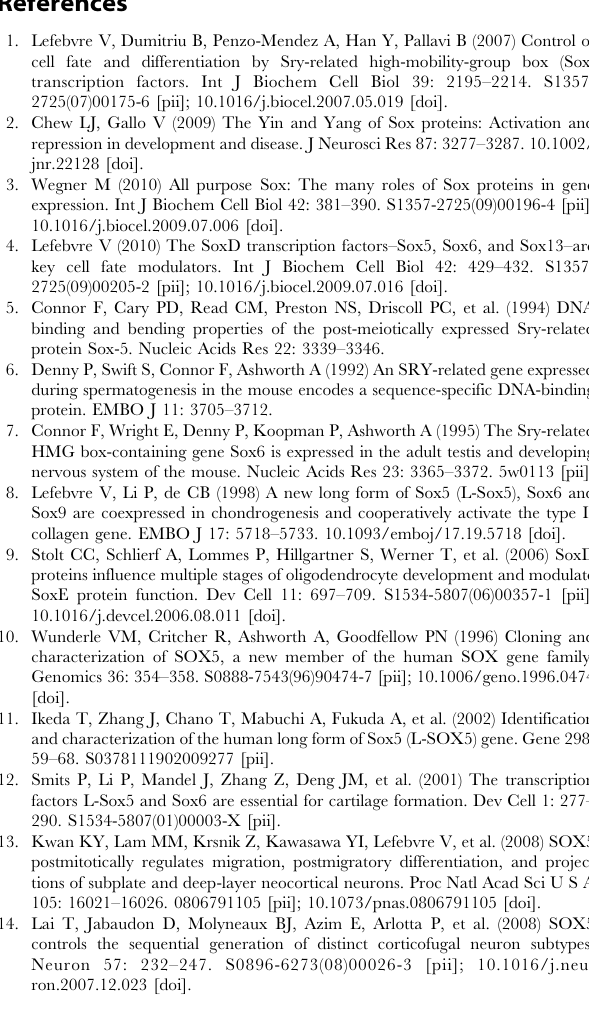
RAJI cell fractions. In agarose gel pictures DNA markers were cut out, since they were loaded between the tested samples and the control sample. Human costal cartilage cells served as a control. Figure S4 Expression of human cell cycle genes in SOX5-transduced and in vitro differentiated human primary B cells. Human cell cycle RT2 Profiler PCR Array containg 84 pathway specific genes were run for RNA samples of GFP- and SOX5-GFP-transduced human primary B cells at day 3 upon CD40L + IL4 + IL21 stimulation in vitro. Negative regulatory genes of cell cycle are indicated in red, whereas positive regulatory genes of cell cycle are depicted in green. Black color shows the regulation of RAD51 gene, which is involved in the homologous recombination and repair of DNA. Dashed lines indicate a threshold of 2 fold up- or down-regulation of genes. Figure S5 Comparison of known functional domains in L-SOX5B and L-SOX5F proteins. Both SOX5 proteins contain the same known functional domains and share the same